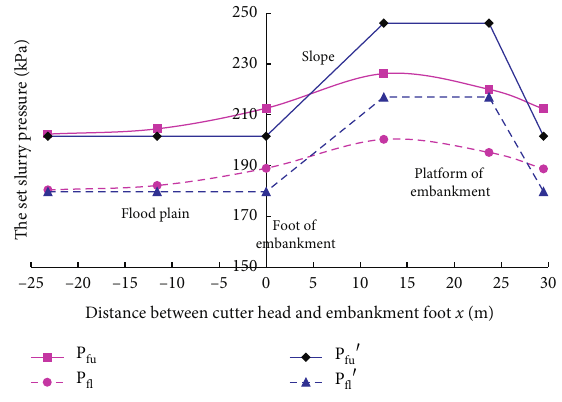
Figure 4: Upper and lower limit value curves of slurry